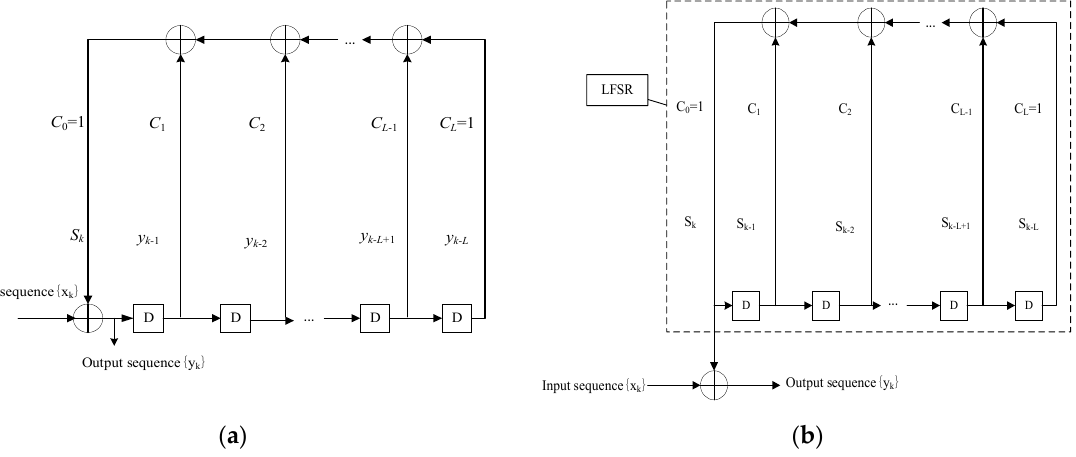
Figure 1. Scrambler schematic. ( a ) Self-synchronous scrambler; ( b ) Synchronous scrambler.